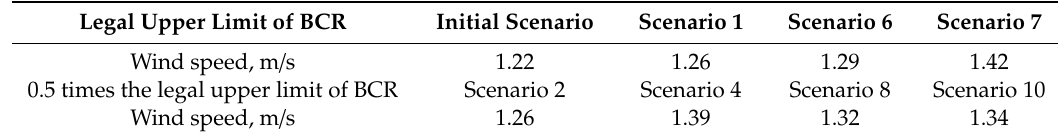
Table 5. Comparison of 24-h averaged mean wind speed between pairs of scenarios with di ff erent BCR values.